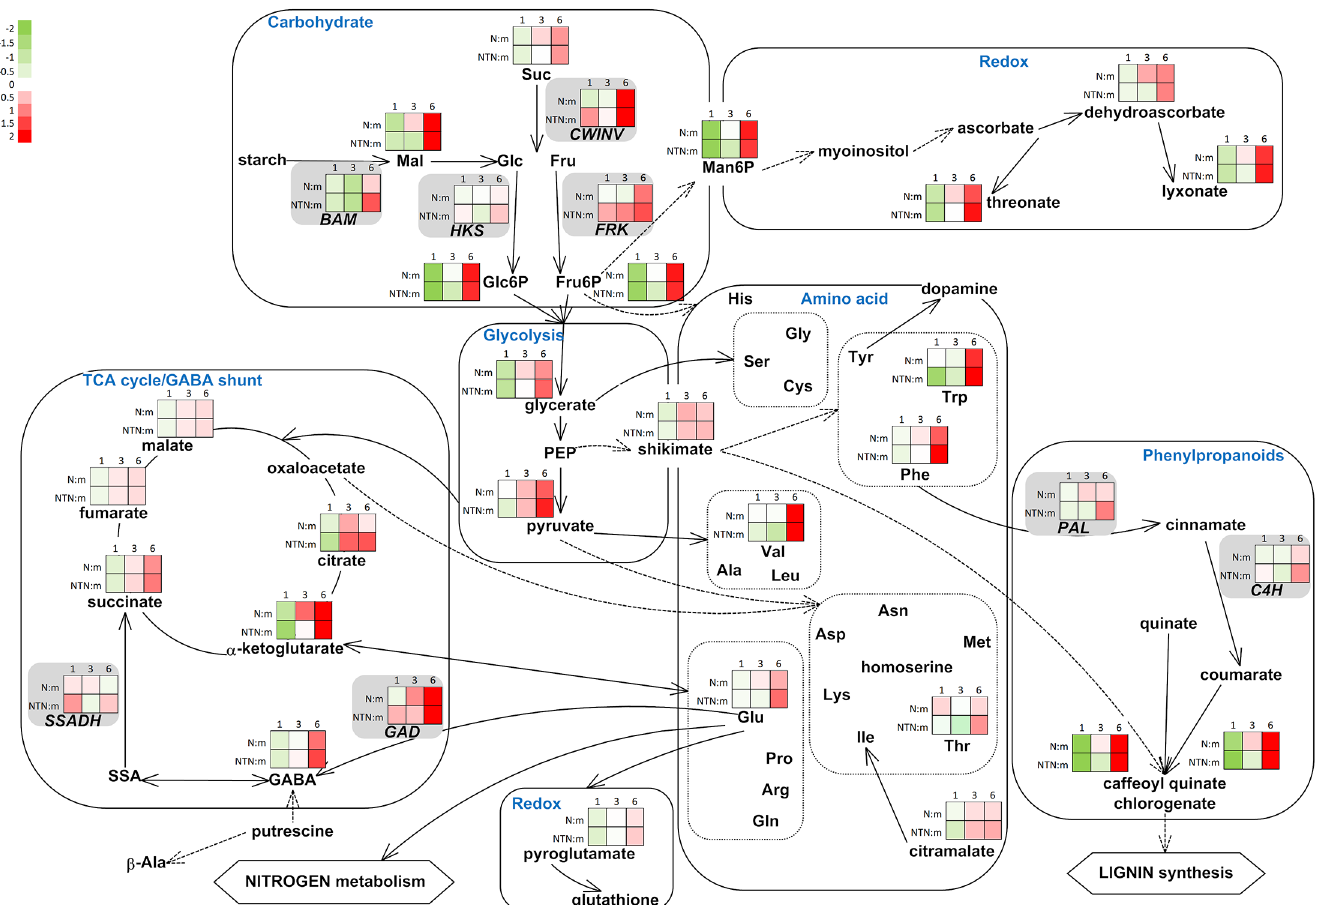
Fig 3. Integration of the changes in the metabolites and transcripts associated with selected metabolic pathways in the PVY N -inoculated and PVY NTN -inoculated leaves, relative to the mock-inoculated leaves. The metabolites identified and the genes analysed from the primary and secondary metabolism and from redox reactions are shown. Each coloured square represents the log2 ratios of the expression or abundance (red, high; green, low) at 1, 3 and 6 dpi in the PVY N -inoculated (N:m) and PVY NTN -inoculated (NTN:m) leaves, relative to the mock-inoculated leaves (as indicated). MapMan BINs linked to primary metabolism: 2.1.1 major CHO metabolism, sucrose synthesis; 2.2.1 major CHO metabolism, sucrose degradation; 2.2.2 major CHO metabolism, starch degradation. MapMan BINs linked to the GABA shunt: 13.1.1.1 amino-acid metabolism, GABA synthesis; 8.1. TCA; 22.